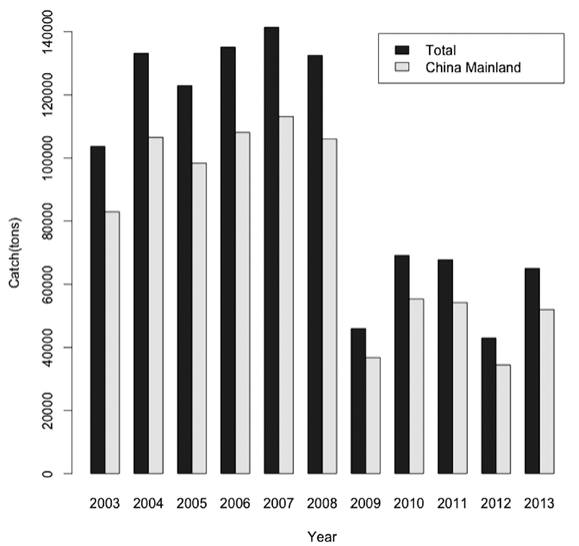
Fig. 1. – Annual total catch of the winter-spring cohort of Ommas- trephes bartramii in the northwest